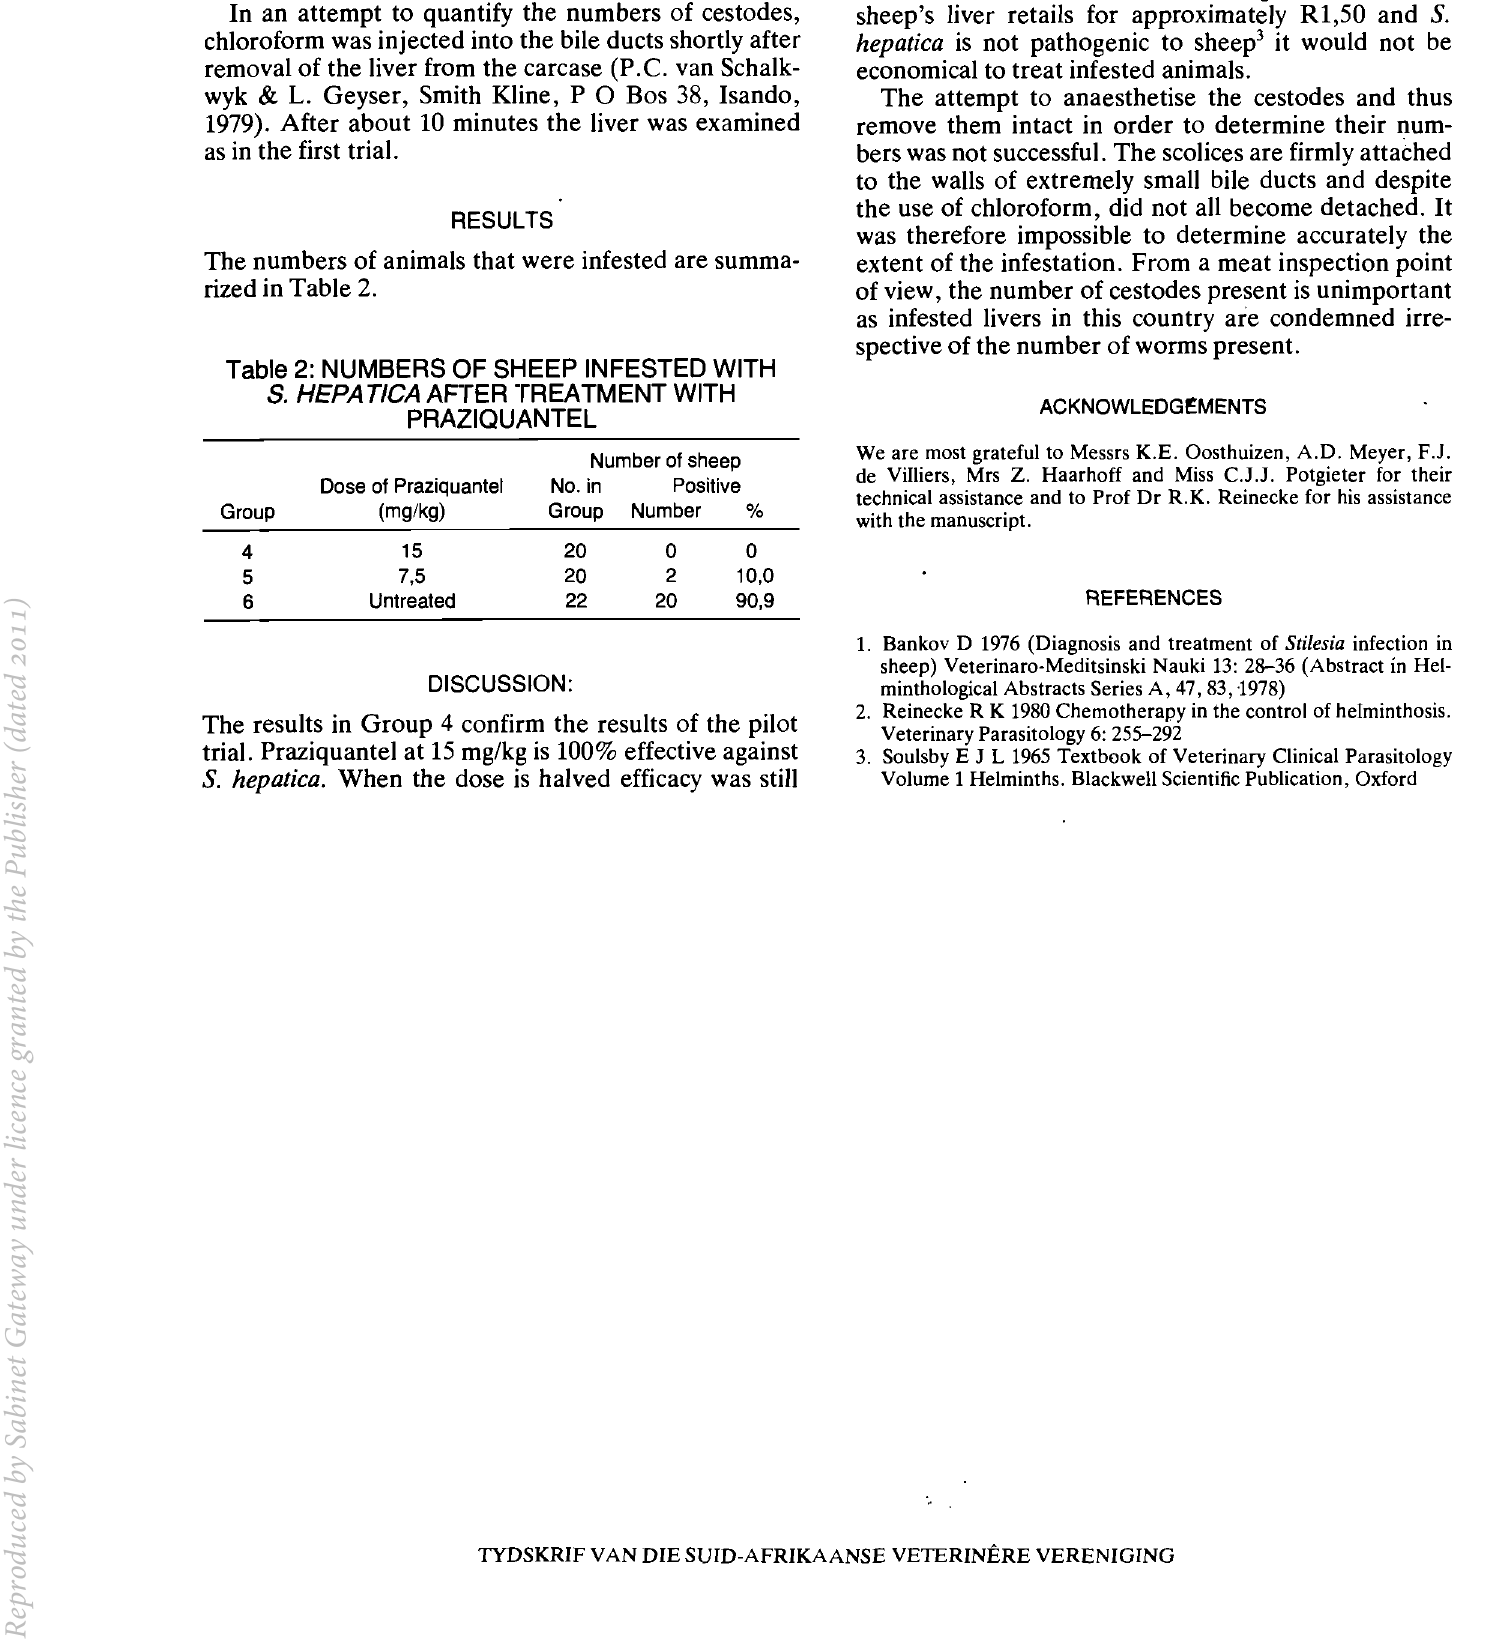
Table 2: NUMBERS OF SHEEP INFESTED WITH S. HEPA TICA AFTER TREATMENT WITH PRAZIQUANTEL Number of sheep Dose of Praziquantel No. in Positive Group (mg/kg) Group Number % 4 15 20 0 0 5 7,5 20 2 10,0 6 Untreated 22 20